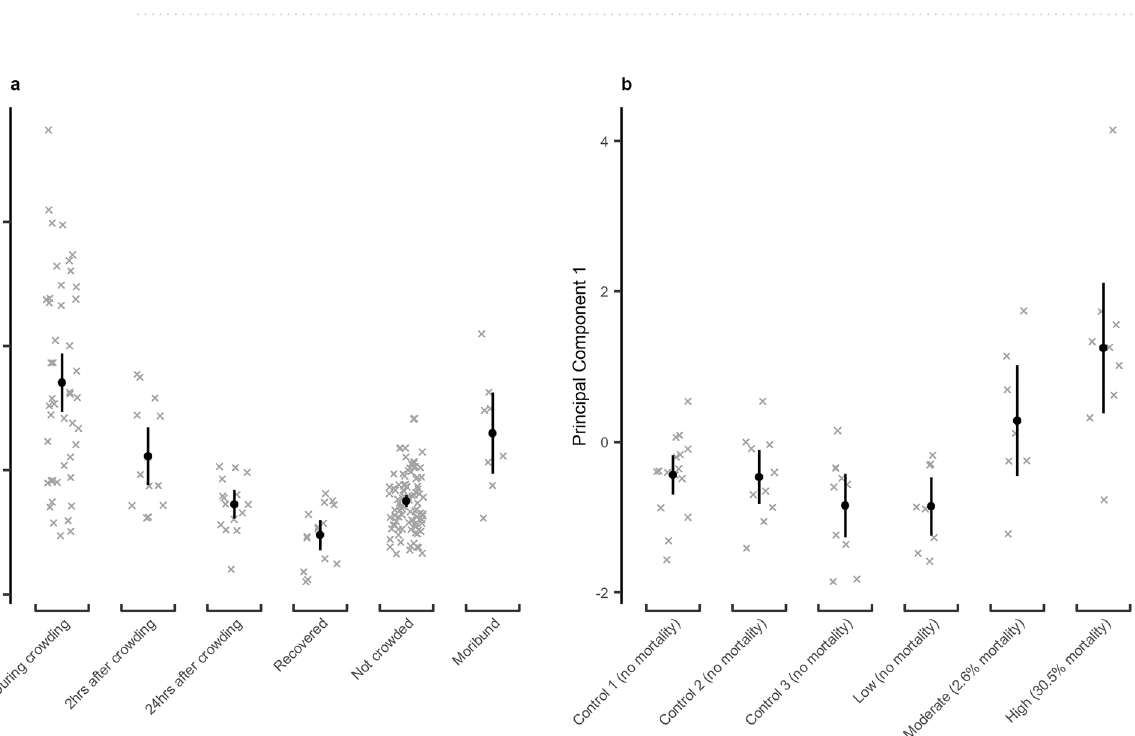
Table 3. Loadings of various Atlantic mackerel ( Scomber scrombrus ) stress responses in a Hill & Smith principal component analysis. Only principal components with eigenvalues > 1 are included.